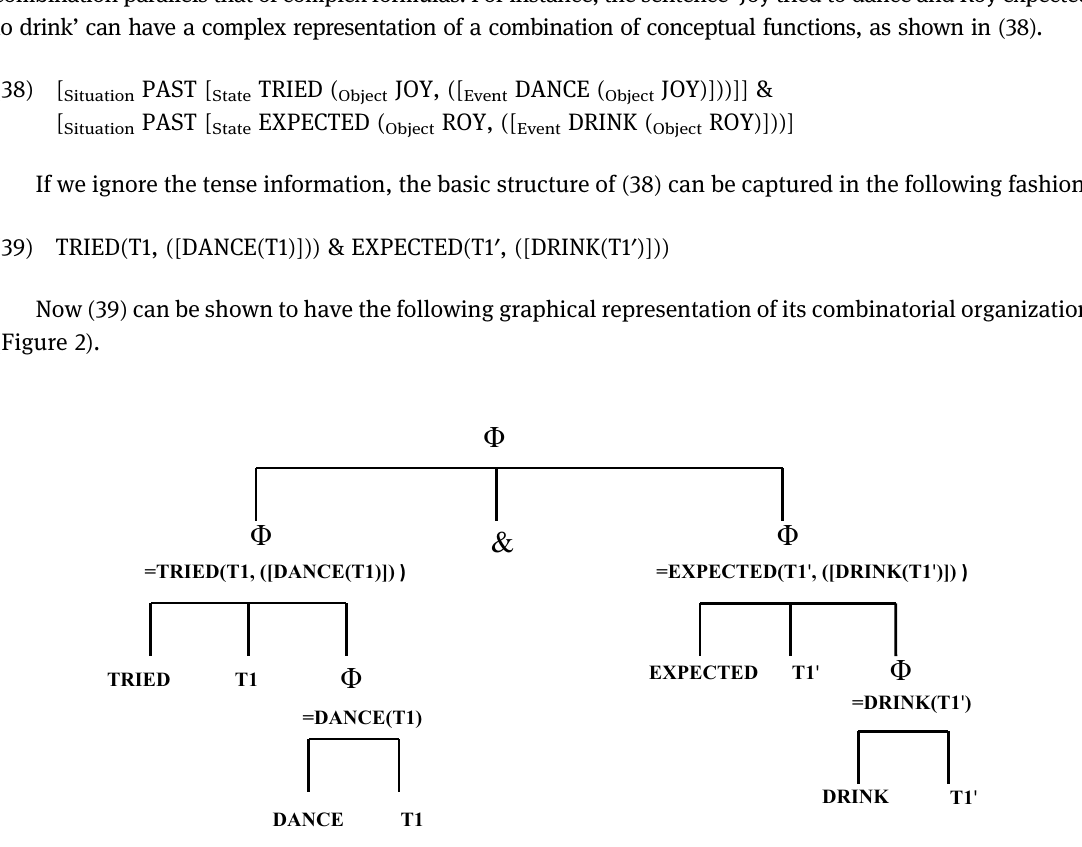
Figure 2: The combinatorial organization of the conceptual functions for ( 39 ) .